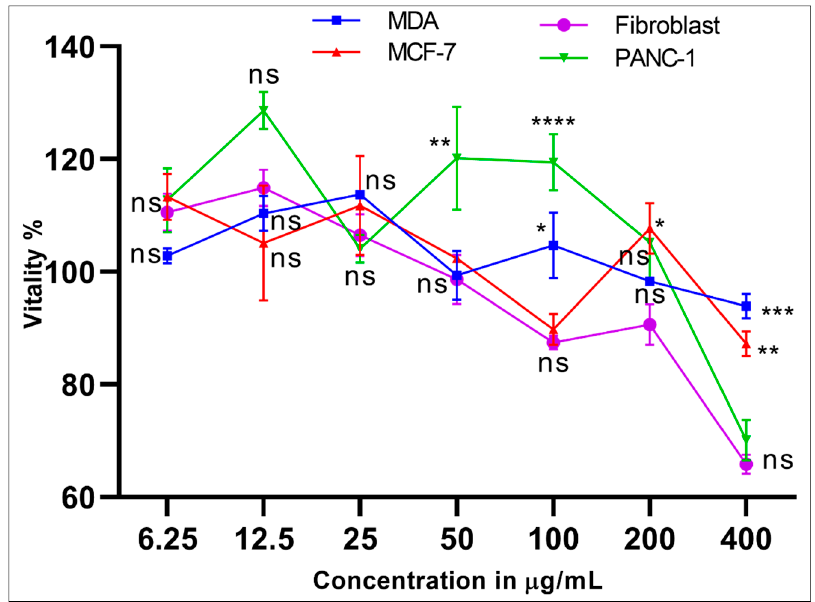
Figure 4. The cell vitality of the S. cyclophylla 95% aqueous-ethanolic extract. Values denoted are mean ± SEM. The statistical significance was performed via a one-way ANOVA followed by a posthoc test using Tukey’s multi-group comparison: ns: not significant, * p < 0.05, ** p < 0.01, *** p < 0.001, and **** p < 0.0001 compared to fibroblasts. For example, at 50 µg/mL compared to the fibroblasts, the MDA and MCF-7 are not significant, while PANC-1 is significant (** p < 0.01).